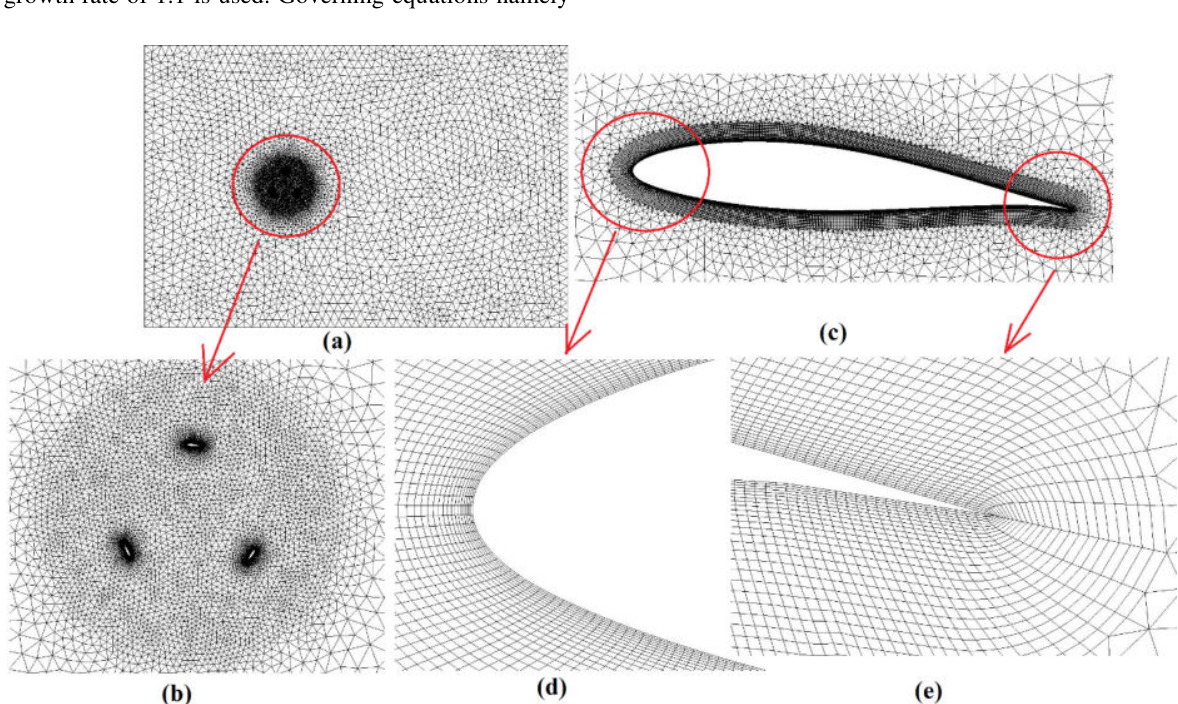
Figure 2 . Computational domain and grid: (a) Domain and grid for VAWT, (b) grid near the rotating cell zone, (c) grid near the airfoil, (d) airfoil leading edge, (e) airfoil trailing edge.